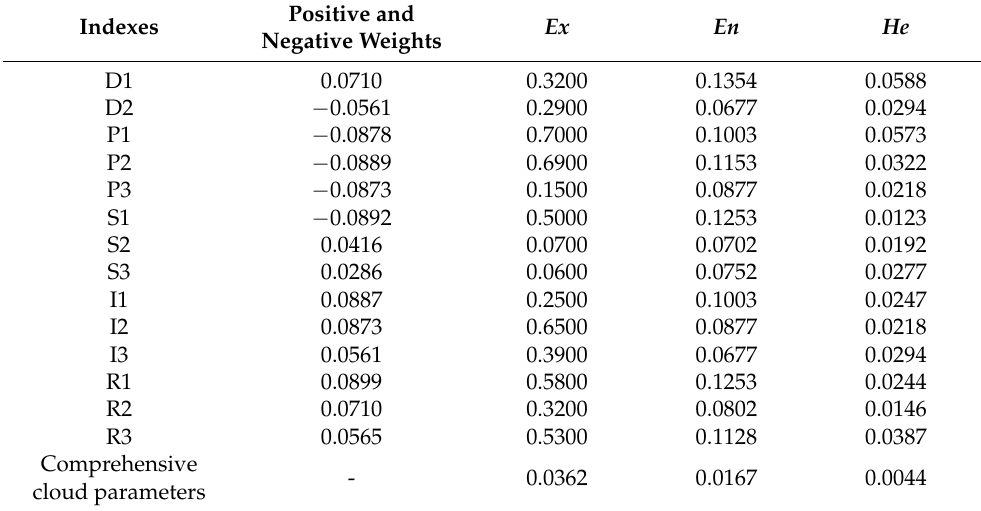
Table 4. Index weights and cloud parameters in the construction period.